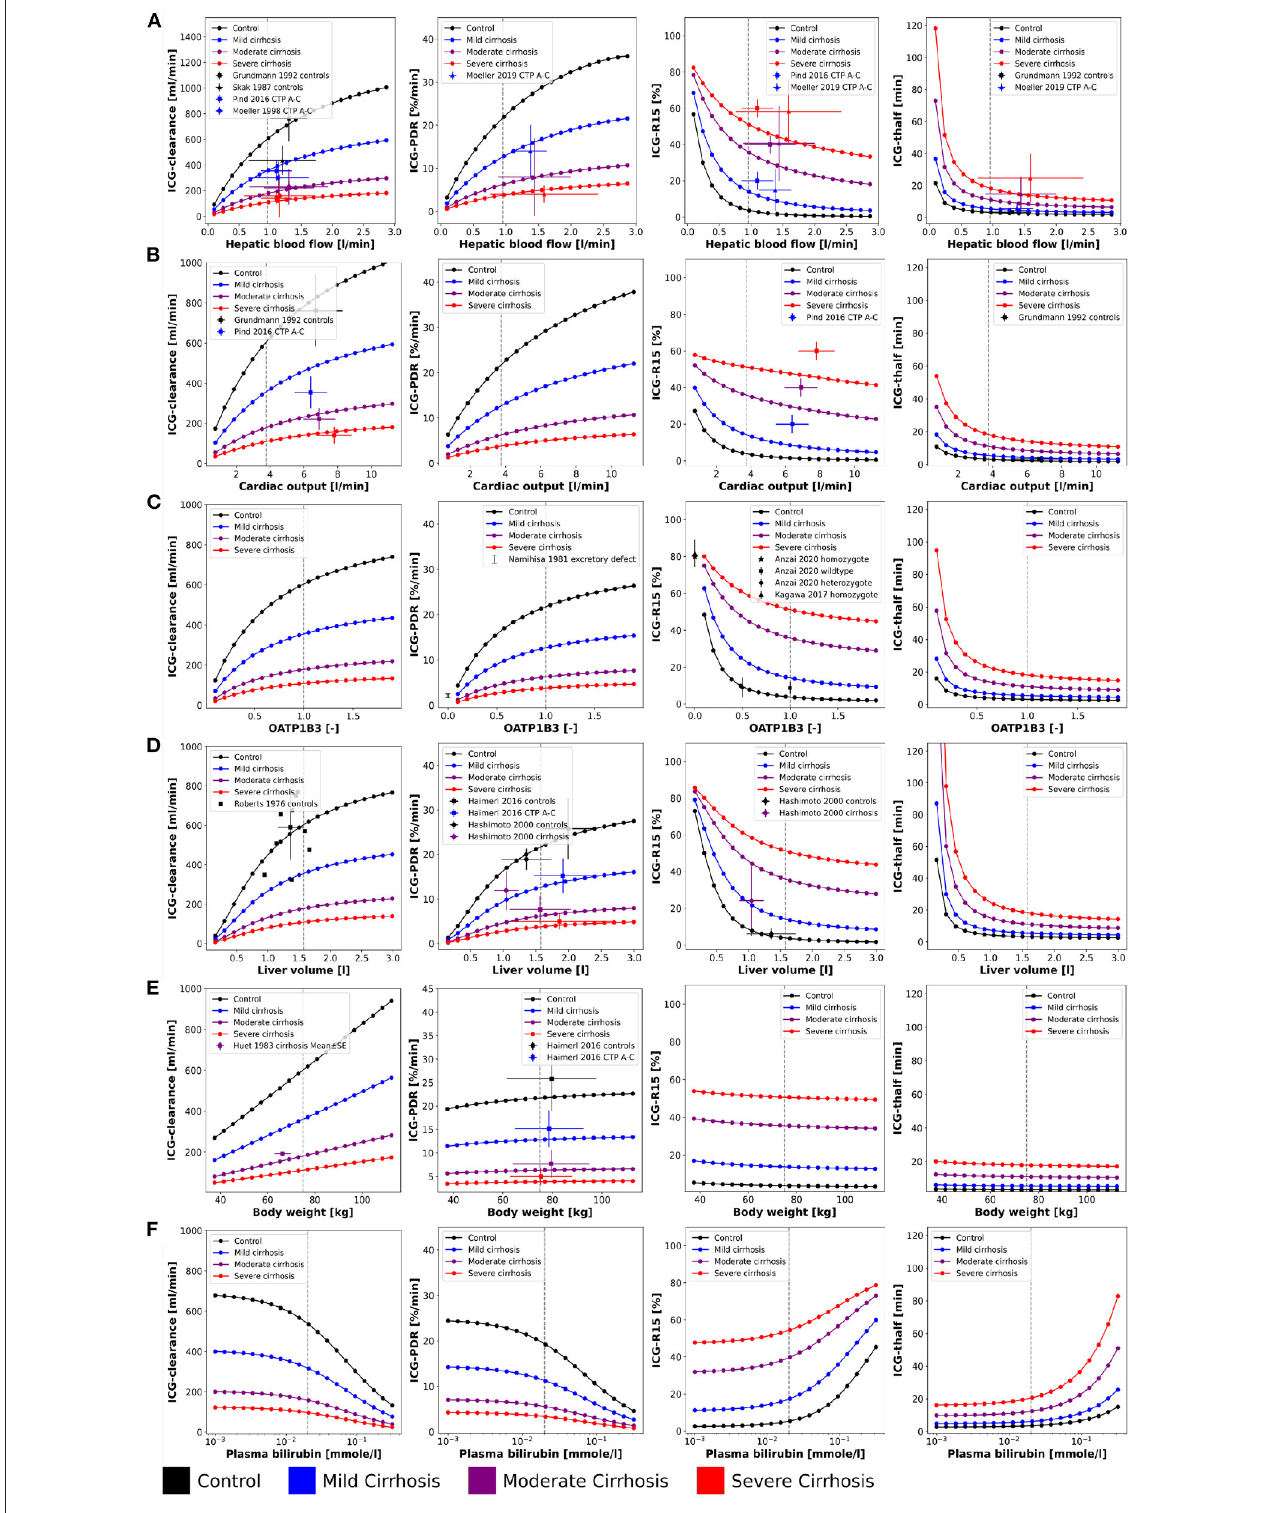
FIGURE 2 | Effect of physiological factors on ICG parameters: The effect of hepatic blood flow, cardiac output, OATP1B3, liver volume, body weight, and plasma bilirubin on ICG-clearance, ICG-PDR, ICG-R15, and ICG-t 1 / 2 were studied. Reference values of the model parameters, i.e., model parameters in